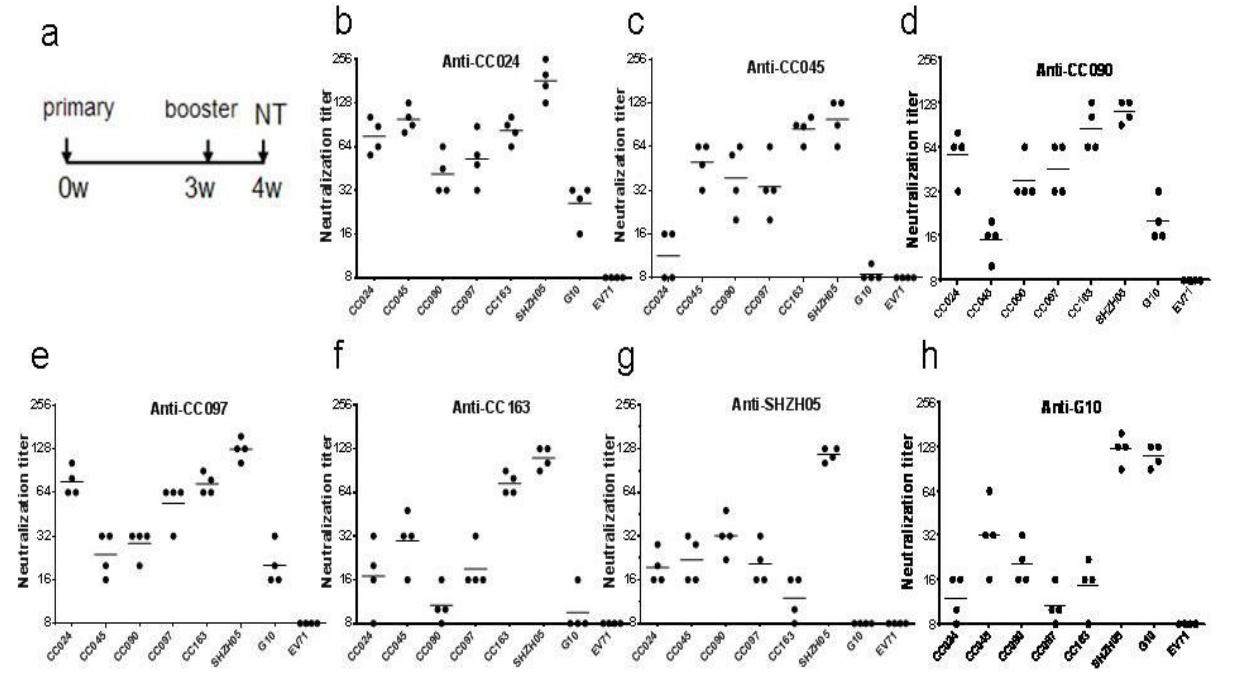
Figure 1. Cross-neutralization assay of various CA16 isolated strains, SHZH05 and G10. ( a ) Immunization schedule for all virus strains; ( b – h ) Serum neutralization titers of CC024, CC045, CC090, CC097, CC163, SHZH05 and G10 against other CA16 and EV71, respectively. Neutralization titers (Y-axis) are plotted on a logarithmic scale.